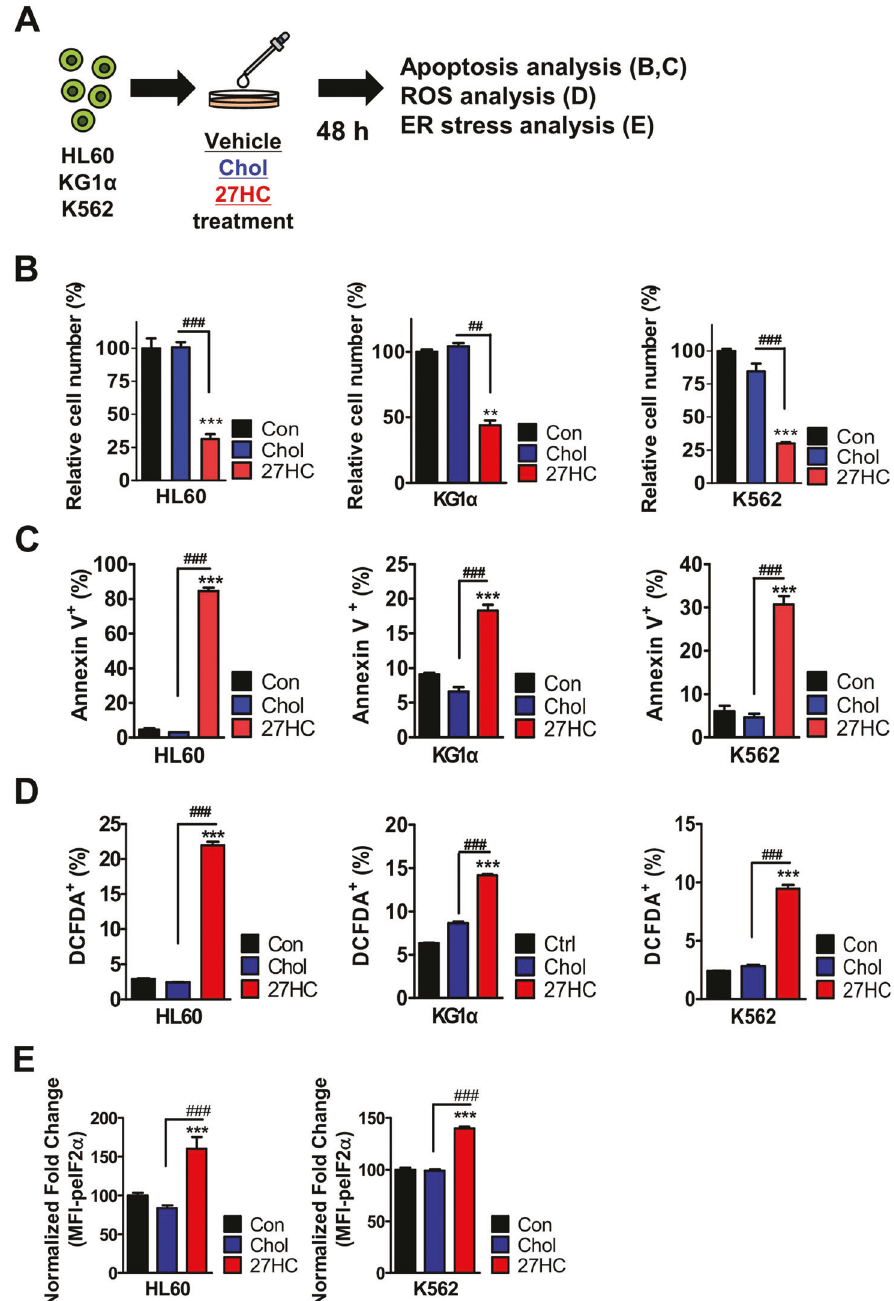
Fig. 4 Exogenous addition of 27HC affects leukemic cell growth in vitro and in vivo. HL60, KG1a, and K562 myeloid leukemic cells are treated with 13 µM Cholesterol or 6.2 µM 27OHChol for 48 h, respectively. A Study overview. B HL60, KG1a, and K562 myeloid leukemic cells were decreased after 27HC treatment. C The exogenous 27HC-treated HL60, KG1a, and K562 myeloid leukemic cells showed a greater percentage of apoptotic cells than did control cells. D The exogenous 27HC-treated HL60, KG1a, and K562 myeloid leukemic cells showed greater ROS production than control cells. E 27HC increases the activity of the ER stress response in HL60 and K562 cells. Data are presented as mean ± SEM. (** p ≤ 0.01 and *** p ≤ 0.001 vs. control; ## p ≤ 0.01 and ### p ≤ 0.001 vs. Chol). ( n = 2 independent experiments and 3 total measurements per